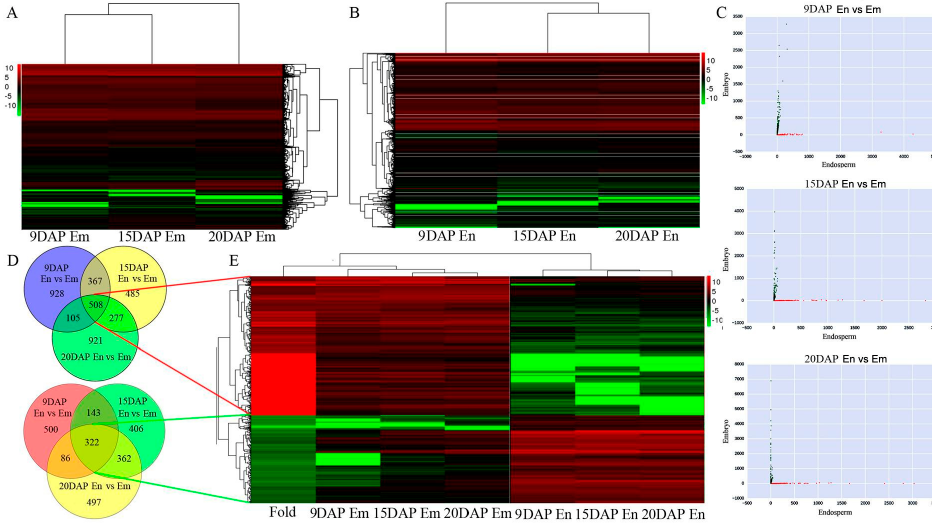
Figure 3. Expression of mRNA during embryo and endosperm development. ( A ) Cluster heat map of mRNA expression at different stages of embryo development. ( B ) Cluster heat map of mRNA expression at different stages of endosperm development. ( C ) Scatter plots showing differentially expressed mRNAs between embryo (black points) and endosperm (red points) at different stages. ( D ) Differentially expressed mRNAs between embryo and endosperm at different stages. ( E ) Hierarchical clustering showing up ‐ and downregulated mRNAs in the two tissues.